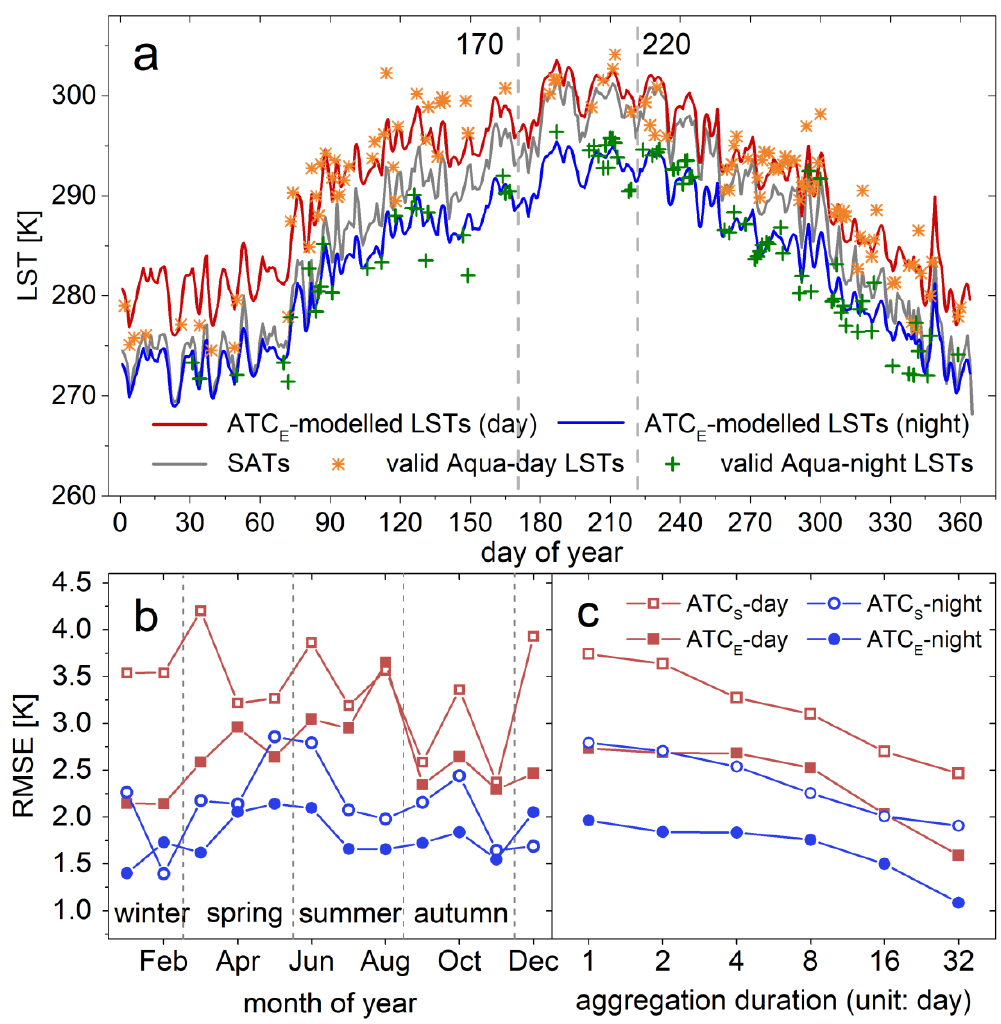
Figure 5. Model performances at different time scales. ( a ) denotes the daily comparisons between the ATC E -predicted and observed LSTs at a selected pixel; ( b , c ) show the model performances at the monthly scale and a series of time scales ranging from 1 to 32 days, respectively.